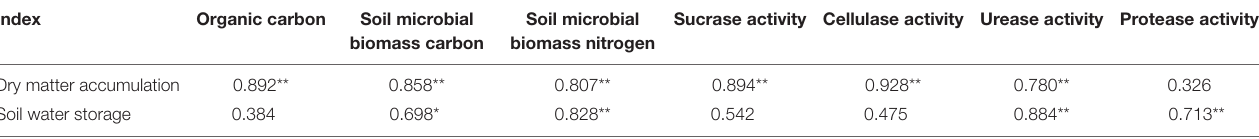
significant ( P < 0.05) or extremely significant ( P < 0.01) positive correlations with yields. Cellulase and urease during the filling and harvest stages showed significant ( P < 0.05) or extremely significant ( P < 0.01) positive correlations with yield. Urease and protease at anthesis stage showed significant ( P < 0.05) or extremely significant ( P < 0.01) positive correlations with yield.